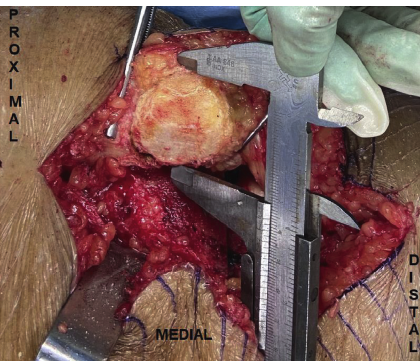
Figure 1: Measurement of left patella’s width using a vernier